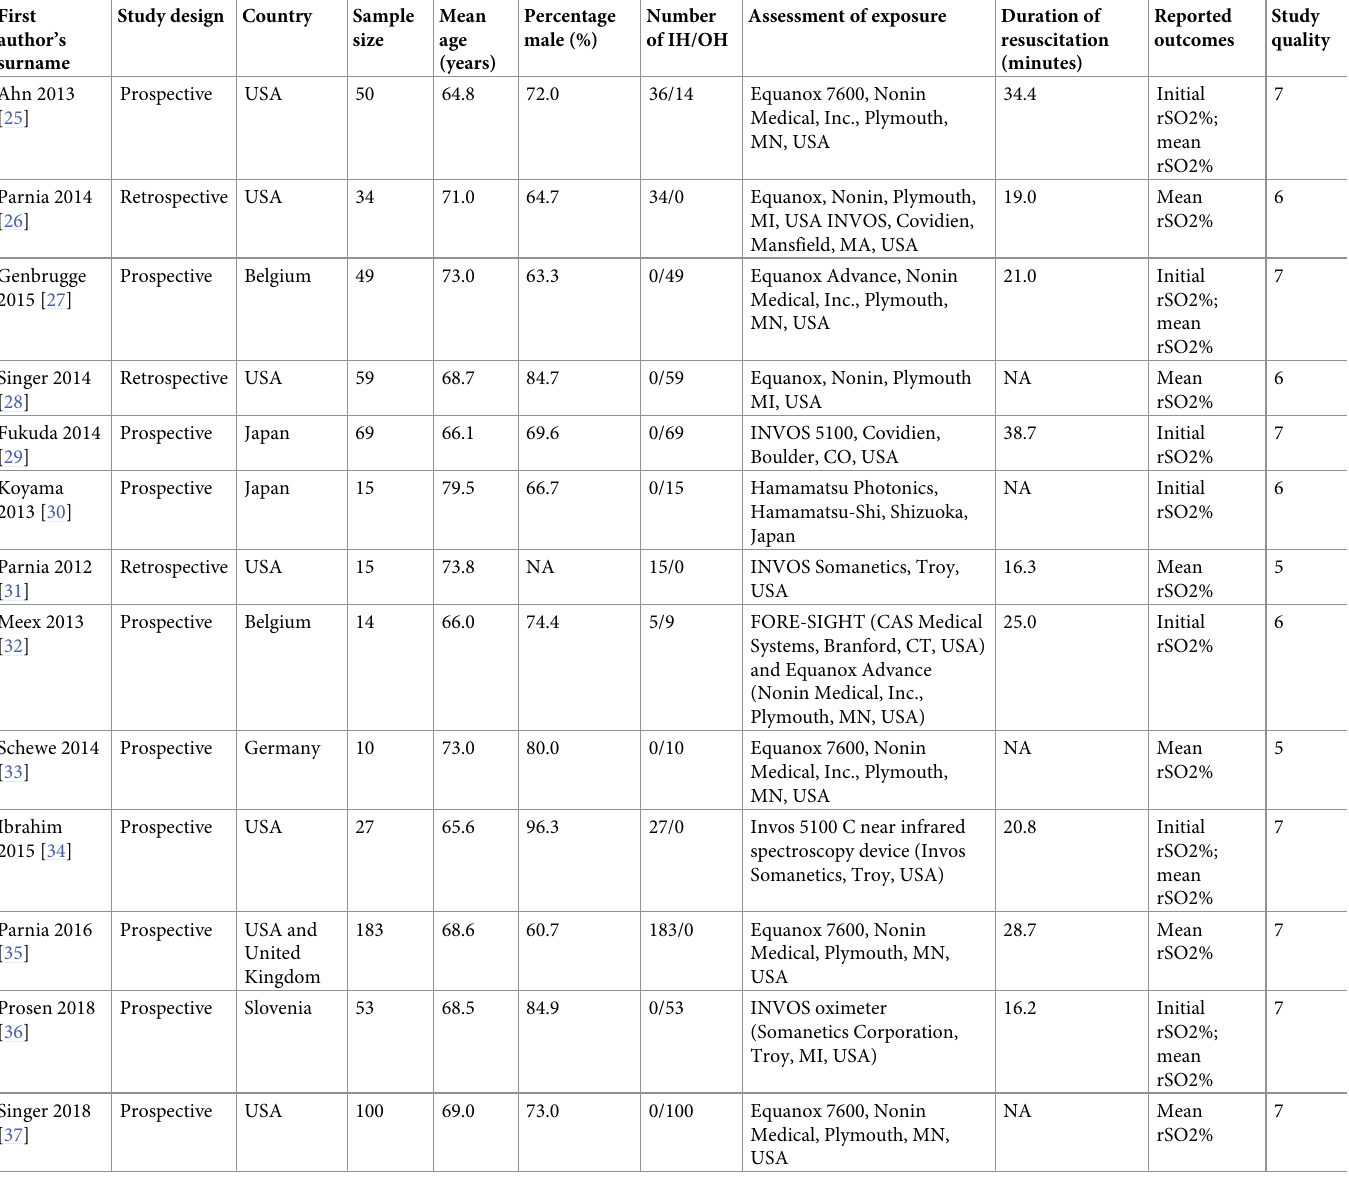
Table 1. Baseline characteristics of included studies and